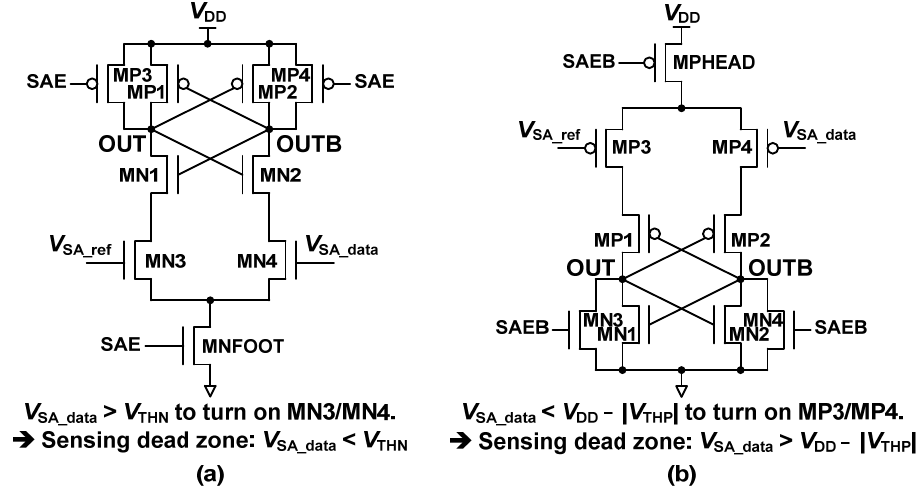
Figure 4. Sensing-dead-zone problem when current-latched SAs (CLSAs) are used in cases of ( a ) footswitch (FS)-CLSA and ( b ) headswitch (HS)-CLSA.